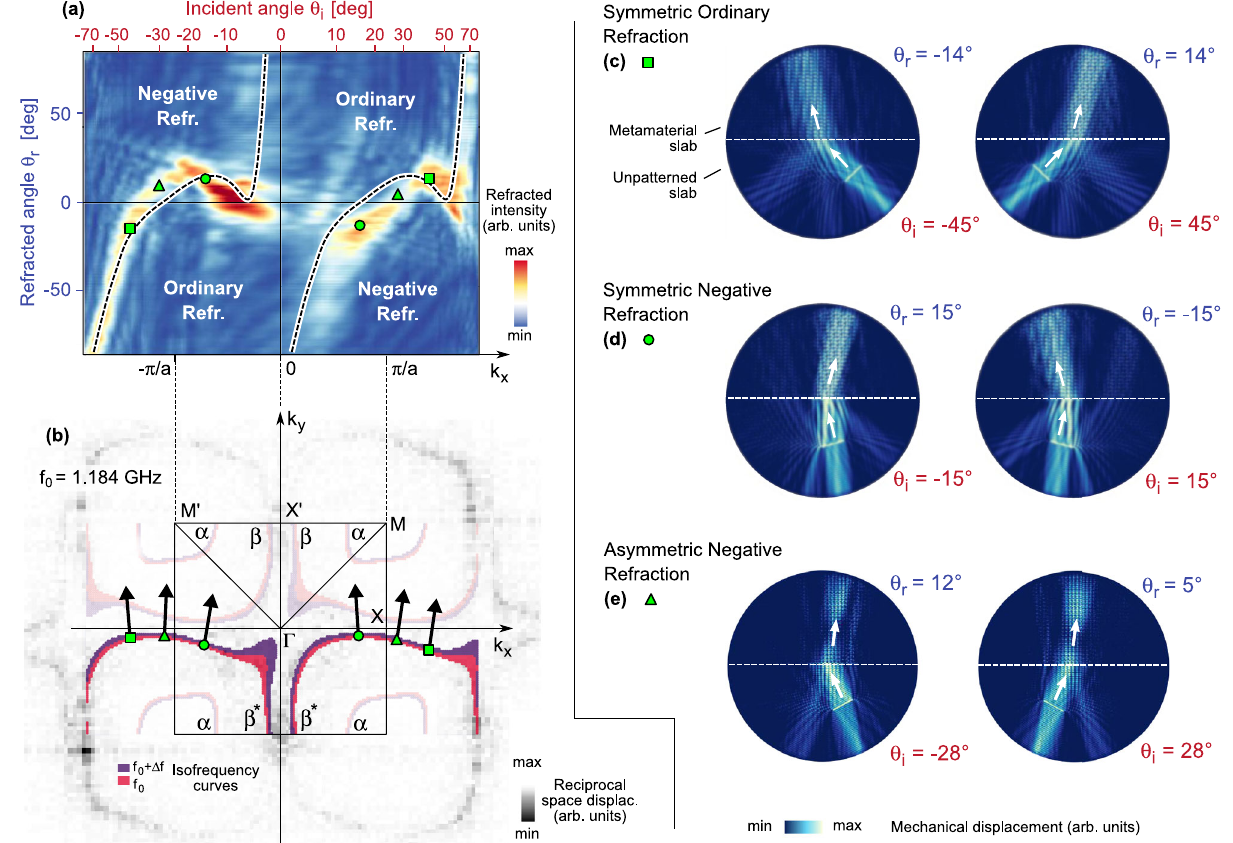
Fig. 4 | Refraction characteristics for the interface between an ordinary slab In the graph, each incident angle corresponds to a certain k x wavevector compo- and the asymmetric phononic metamaterial. a Color map of the refracted wave nent, as provided by the double horizontal axis. Panel b reports as colored traces intensity as a function of the incident and refracted angles, as calculated with the thecalculatedisofrequencycurvessuperimposedwiththemeasuredmetamaterial full-domain 3Dd fi nite-element model. The black dashed line represents the reciprocal space displacement map (grayscale). The data are the same as in refraction relation determined from the gradient of the isofrequencycurves. From Fig.3c – f,butasymmetricdomainover k y hasbeenhereemployed;moreover,only therelevantsectionsofmode β (labeledas β *)areherehighlighted. c – e Colormaps the colormap, negative refraction (i.e., sign( θ i )= − sign( θ r )) occurs for − 40°< θ i < − 8°and for0°< θ illustrating the refracted beams in the various regimes enabled by the asymmetric i <25°;moreover,themapisnotinvariantundertheexchangeof metamaterial. The corresponding points in panels a , b are identi fi ed as green ( θ i , θ r ) with ( − θ i , − θ r ). These observations indicate the existence of asymmetric negativerefraction,thathappensattheanglepairidenti fi ed bytriangularmarkers.